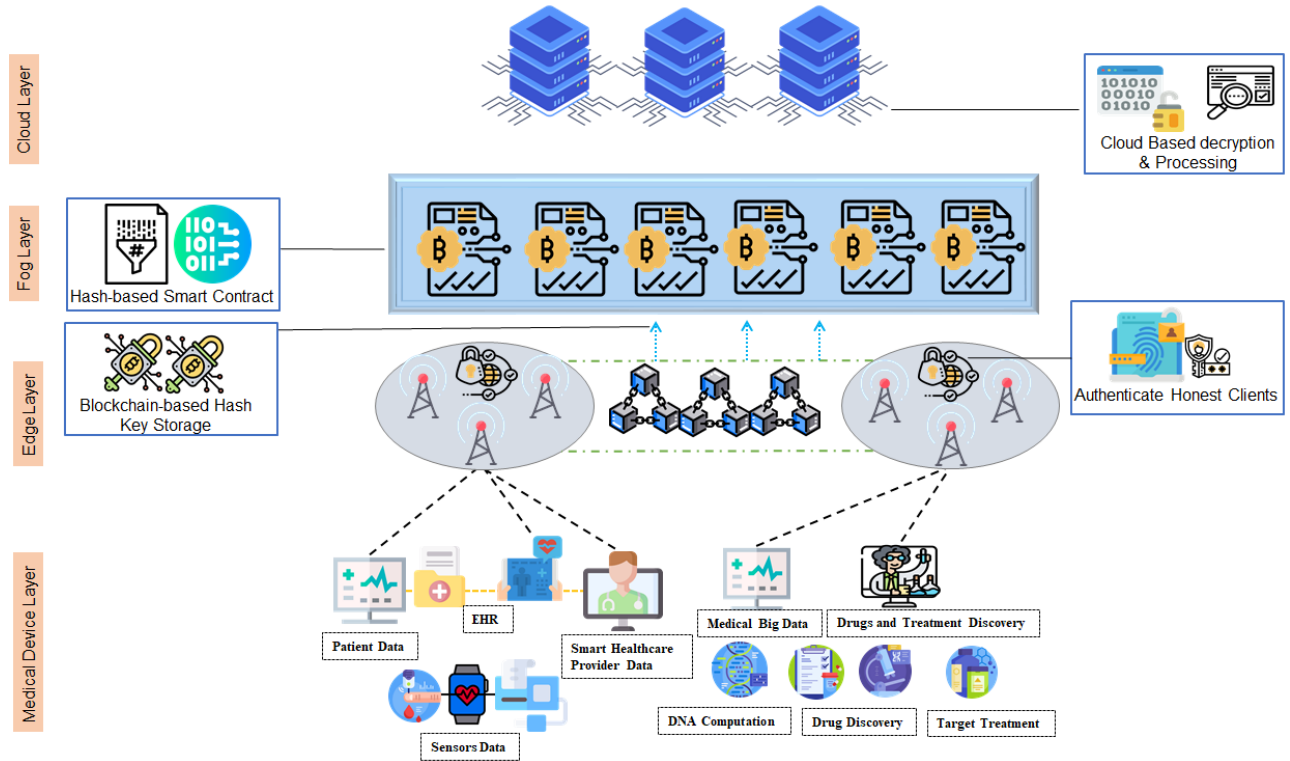
Figure 1. Proposed Blockchain-based IHT Architecture.